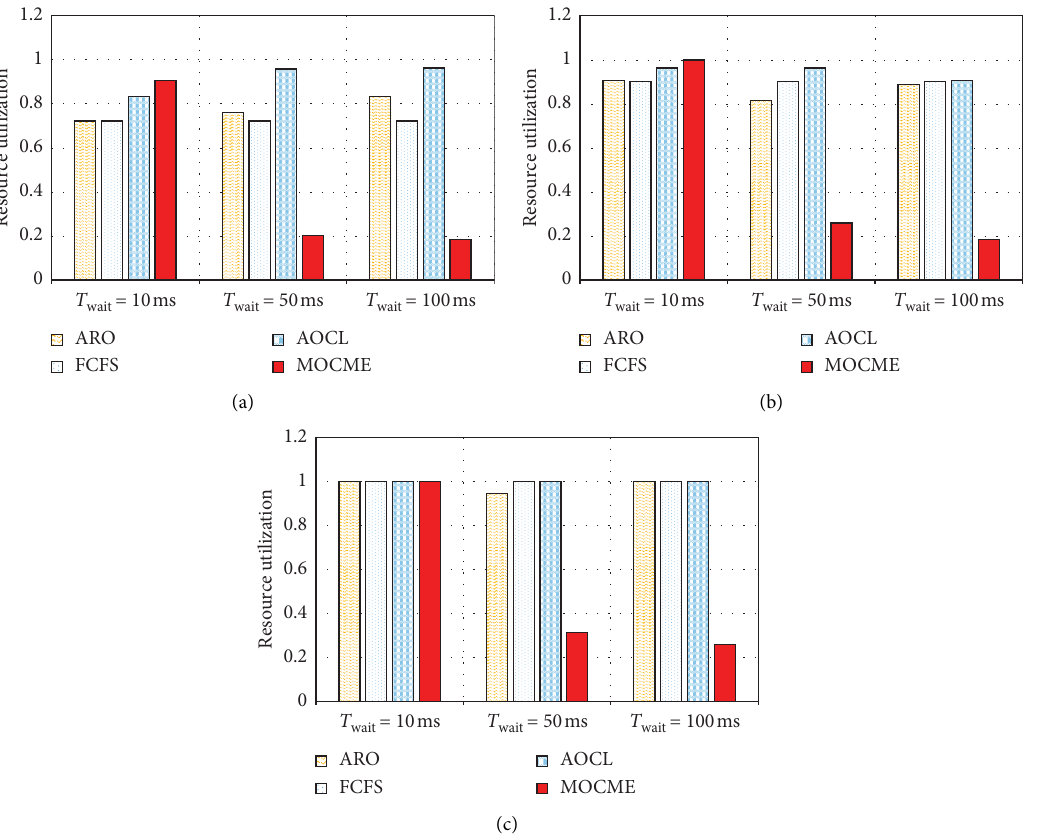
Figure 8: Average resource utilization of the cloudlets. (a) Number of WAs � 4. (b) Number of WAs � 5. (c) Number of WAs �